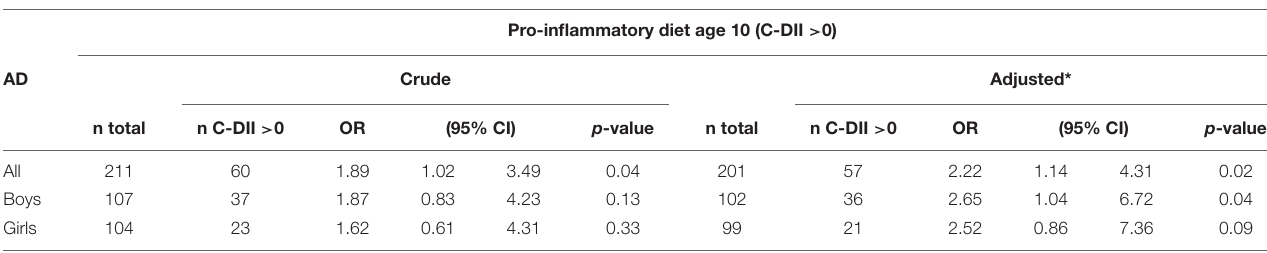
TABLE 5 | Pro-inflammatory C-DII and atopic